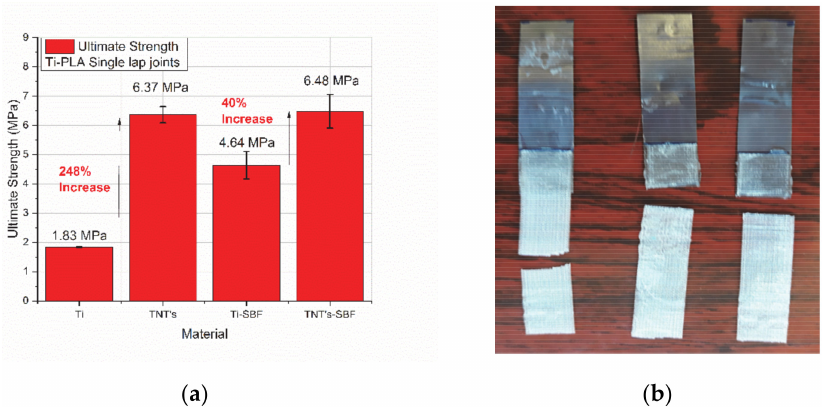
Figure 8. ( a ) Ultimate strength after micro-tensile testing: Ti: titanium-PLA joints, TNTs: titanium dioxide nanotubes -PLA joints, Ti-SBF: titanium-PLA joints after 8 h SBF, TNTs-SBF: titanium dioxide nanotubes -PLA joints after 8 h immersion in SBF and ( b ) PLA yielding mode in joints with TNTs on the titanium